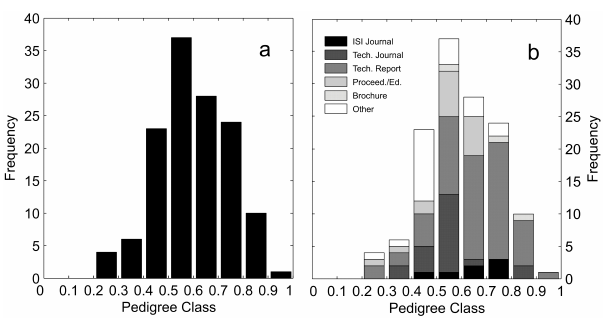
Fig. 3. Histogram of the pedigree results for all evaluated flood re- ports (a) , and further stratified by reference type (b)